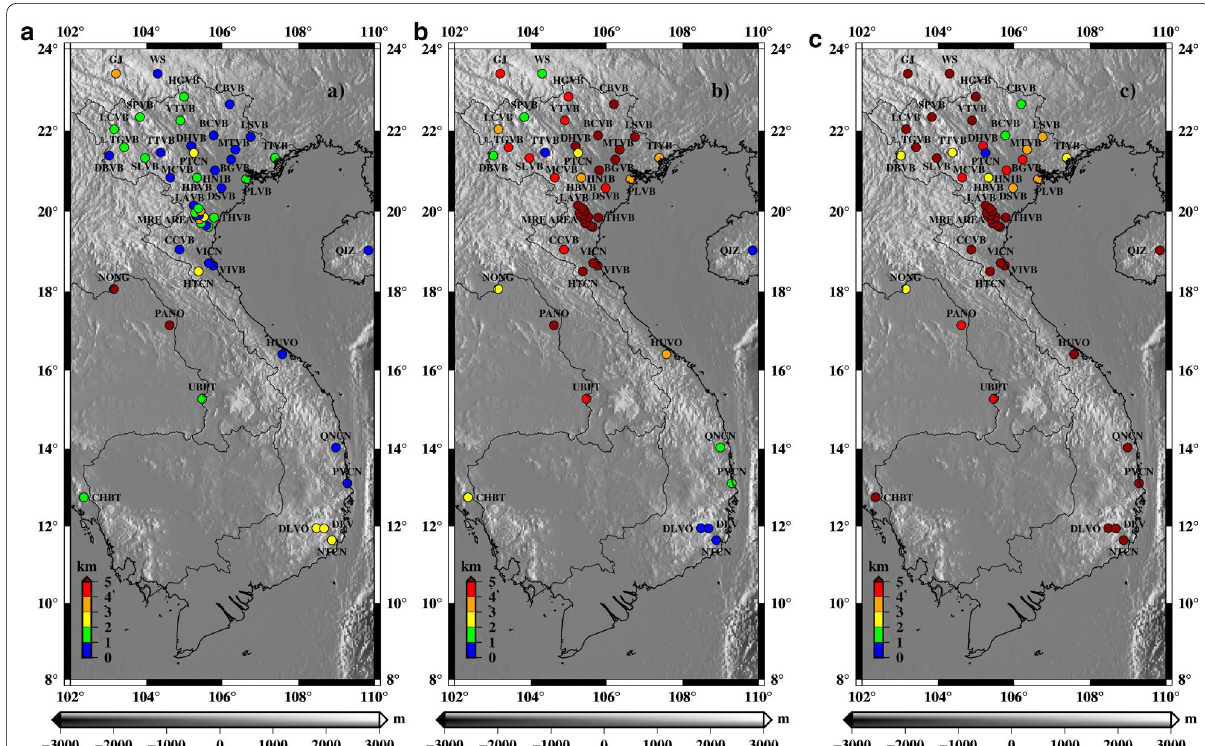
Fig. 12 Absolute differences between Moho depths from the Moho_GEOID, CRUST1.0, and GEMMA with those of the seismic stations: a Moho_ GEOID, b CRUST1.0, and c